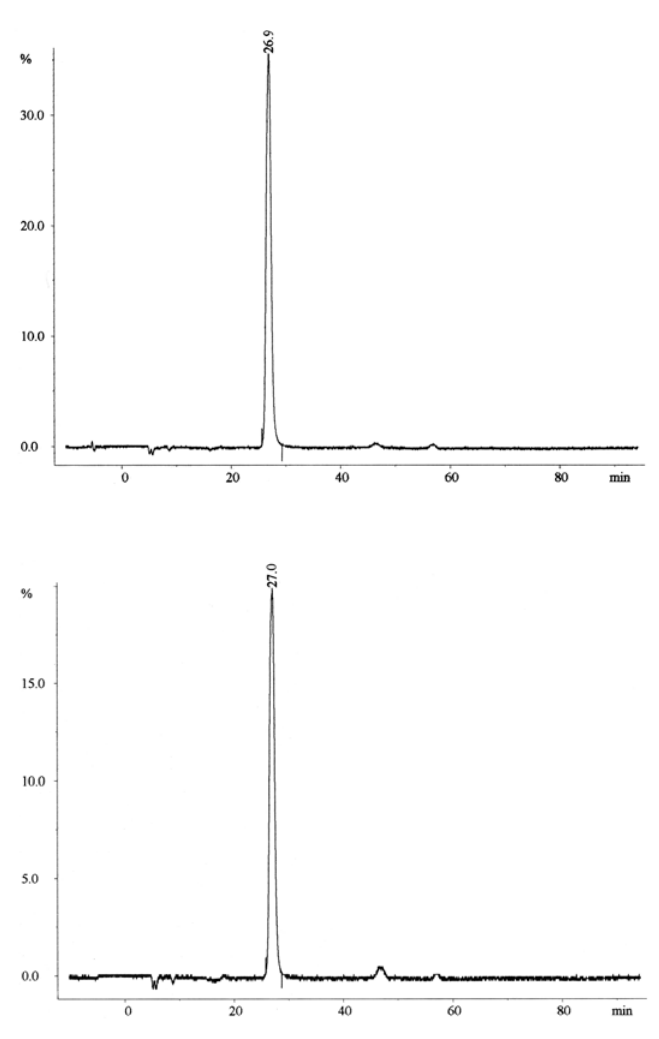
Fig. 2 – Chromatogram (HPLC) corresponding to the synthesized sample (top) and Sigma standard (botton),